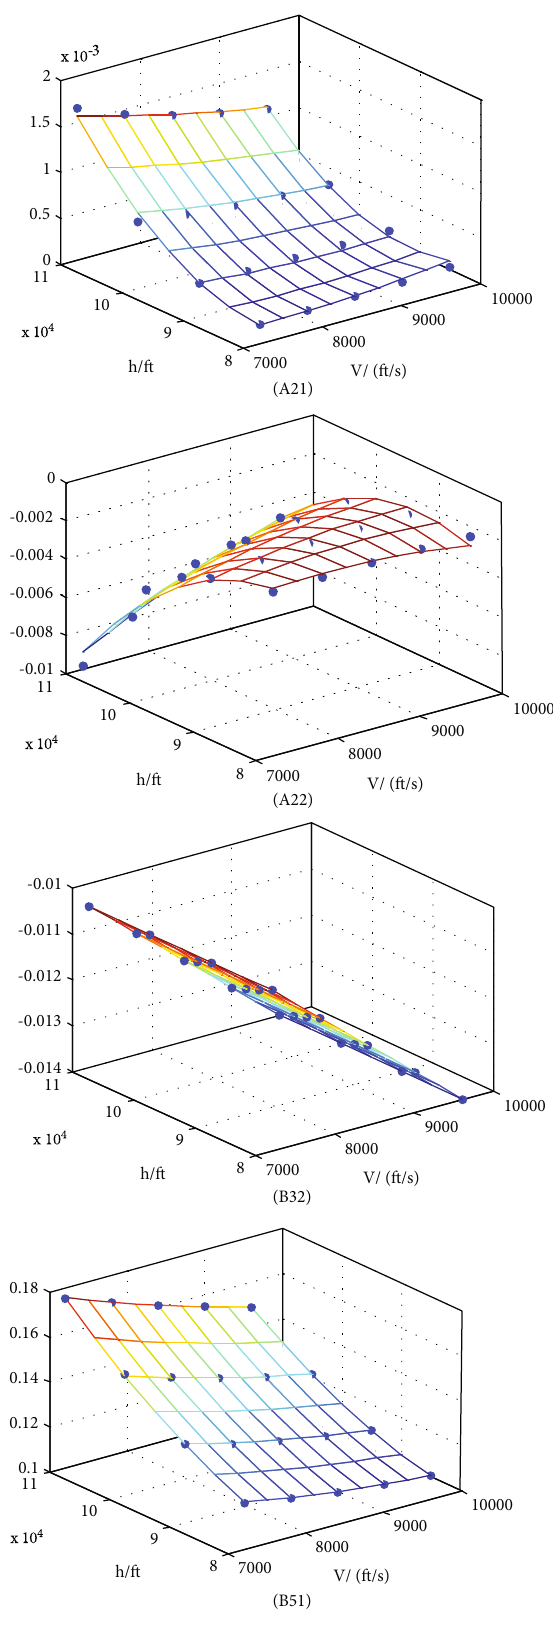
Figure 2: The fi tting e ff ect of LPV model